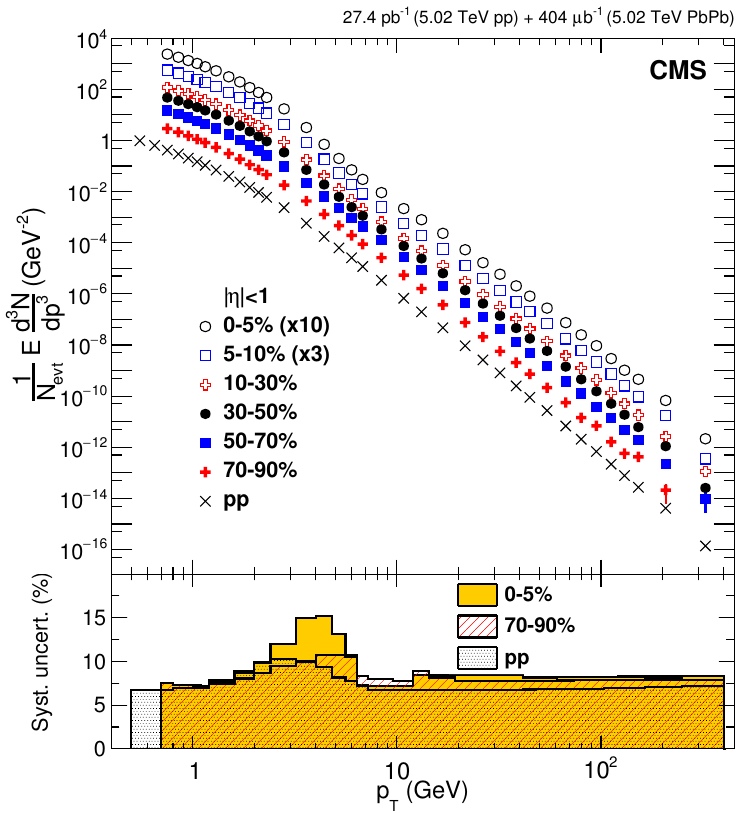
Figure 2 . (Top panel) Charged-particle per-event yields measured in various PbPb centrality classes, as well as in pp data. A factor of 70 mb is used to scale the pp spectrum from a di(cid:11)erential cross section to a per-event yield for direct comparison. The statistical uncertainties are smaller than the size of the markers for most points. (Bottom panel) Systematic uncertainties as a function of p T for representative data sets. The pp uncertainty contains a 2.3% fully correlated uncertainty in the pp integrated